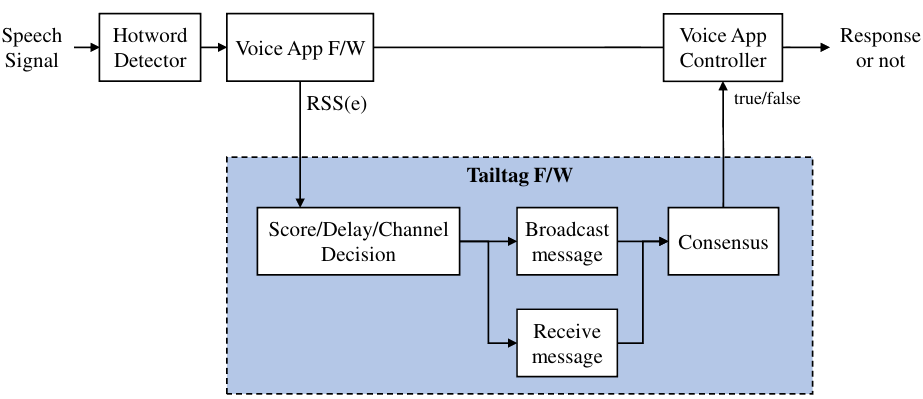
Figure 11. The tailtag integration with existing voice app framework.